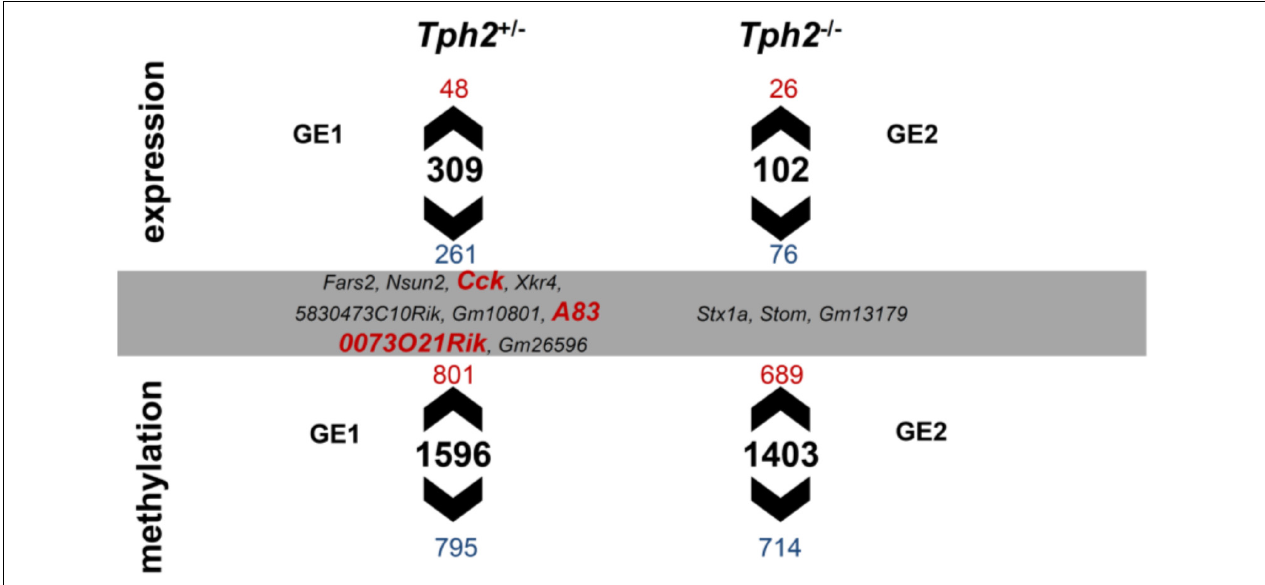
FIGURE 4 | Overlap between differentially expressed genes (DEGs) and differentially methylated loci (DMLs) in the amygdala of mice that were exposed to maternal separation (MS) and are offspring of tryptophan hydroxylase 2-deficient ( Tph2 + / − ) parents. For statistical analysis of RNA expression and DNA methylation, contrasts were calculated for Tph2 ∗ MS interactions GE1 [( Tph2 + / − MS- Tph2 + / − C)-( Tph2 + / + MS- Tph2 + / + C)] and GE2 [( Tph2 − / − MS- Tph2 − / − C)-( Tph2 + / + MS- Tph2 + / + C)]. Per group 8 samples (total 48 samples were sequenced for either analysis). For DNA methylation data, pre-analysis quality control revealed two outlier samples, both of the Tph2 − / − MS condition, which were excluded from analysis. Genes of either analysis were determined differential if they showed a nominal p < 0.01 and lg2FC > | 0.2| . Fars2, phenylalanine-tRNA synthetase 2 (mitochondrial); Nsun2, NOL1/NOP2/Sun domain family member 2; Cck, cholecystokinin; Xkr4, X-linked Kx blood group related 4; 5830473C10Rik, RIKEN cDNA 5830473C10 gene; Gm10801, predicted gene 10801; A830073O21Rik, RIKEN cDNA A830073O21 gene; Gm26596, predicted gene 26596; Stx1a, syntaxin 1A (brain); Stom, stomatin; Gm13179, predicted gene